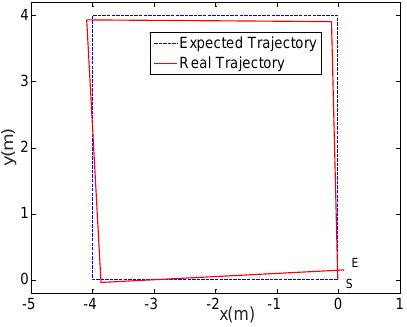
Figure 11. Motion trajectory error when the robot moves along a square.